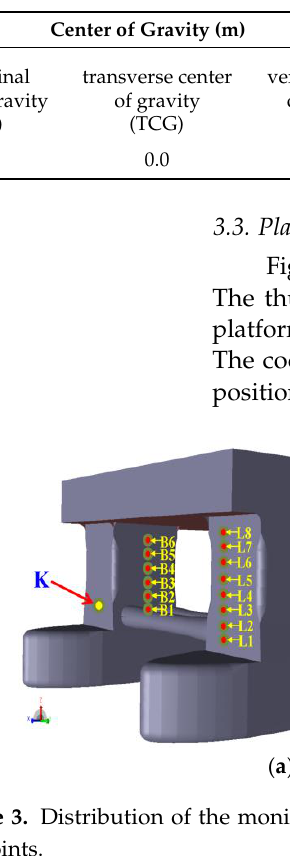
Table 3. Hydrostatic parameters of full-scale model.